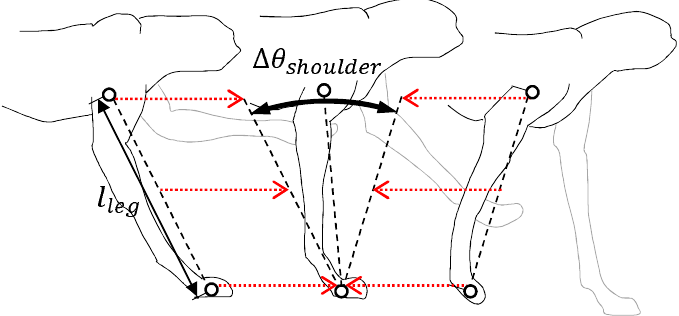
Figure 8. The locomotion of the front-leg during the stance